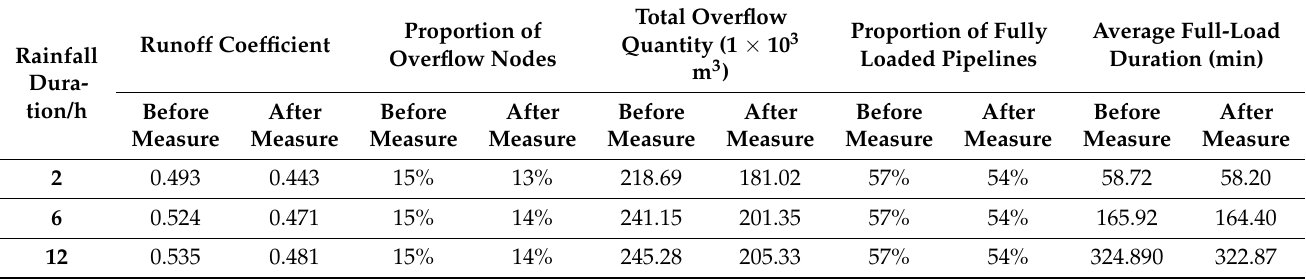
Table 14. Statistical analysis on drainage capacity under different rainfall